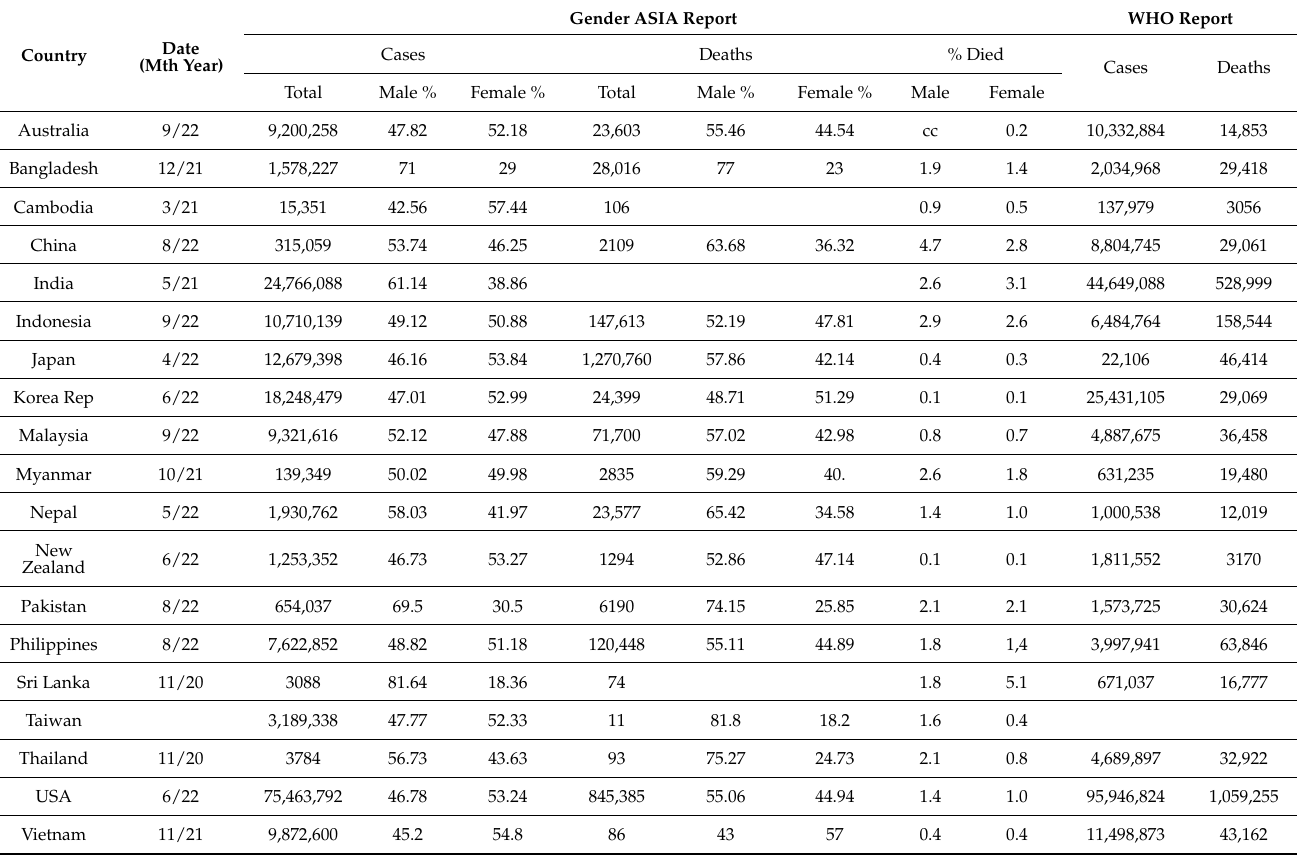
Table 1. COVID-19 Cases and Deaths by Gender ASIA (Selected